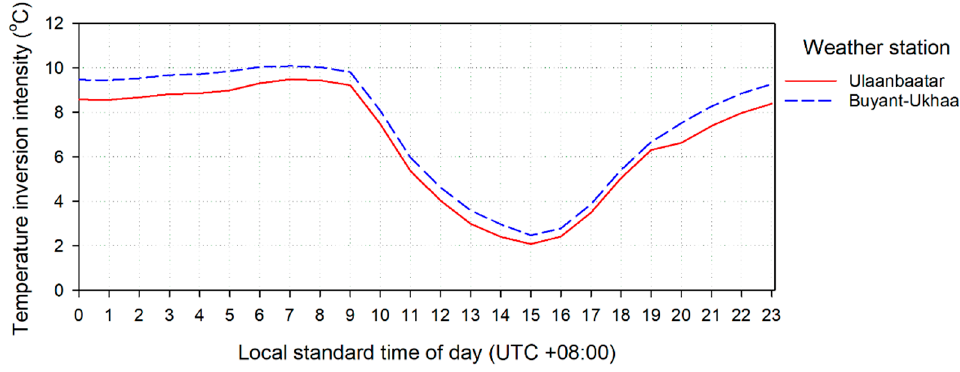
Figure 10. Diurnal variations in the near-surface temperature inversion intensity for Buyant-Ukhaa and Ulaanbaatar weather stations in winter.